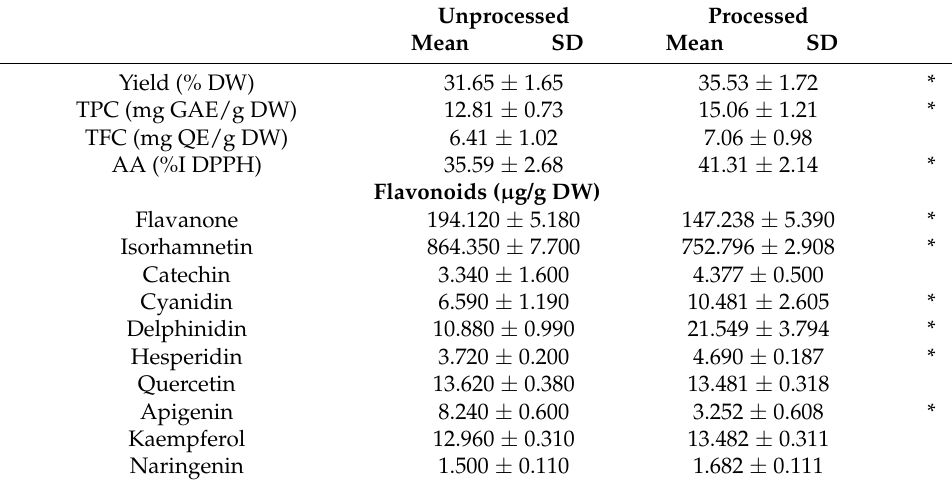
Table 2. The extraction yield, total phenolic content (TPC), total flavonoid content (TFC), antioxidant activity (AA), and specific flavonoid concentrations in ethanolic extracts obtained from unprocessed and processed bagasse of Agave lechuguilla